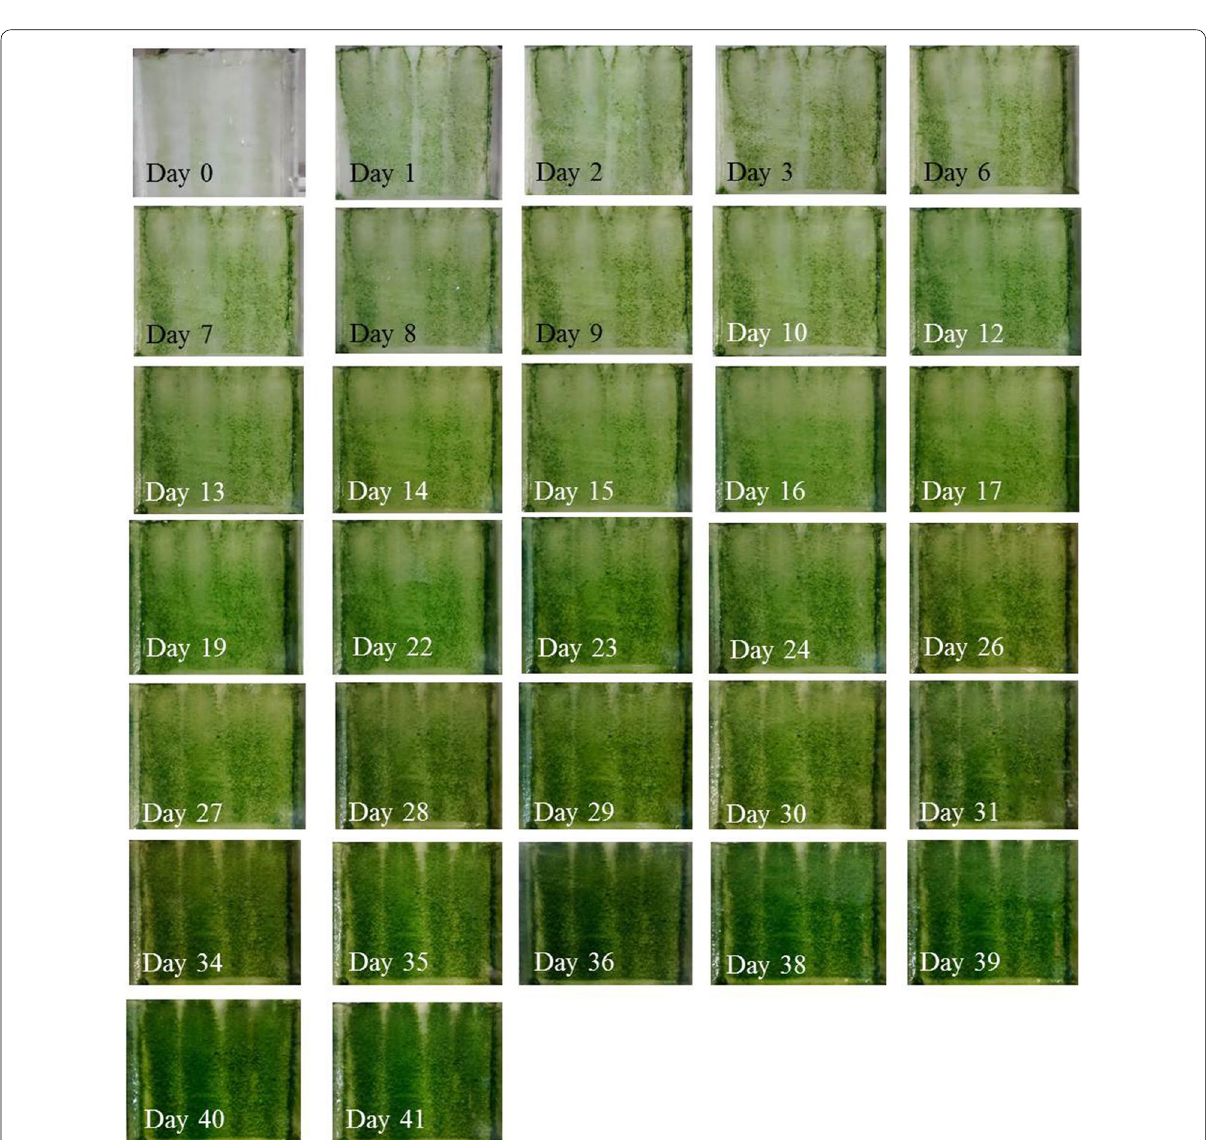
Fig. 6 Photographic record of C. vulgaris ACUF 809 biofilm development on cotton fabric in the